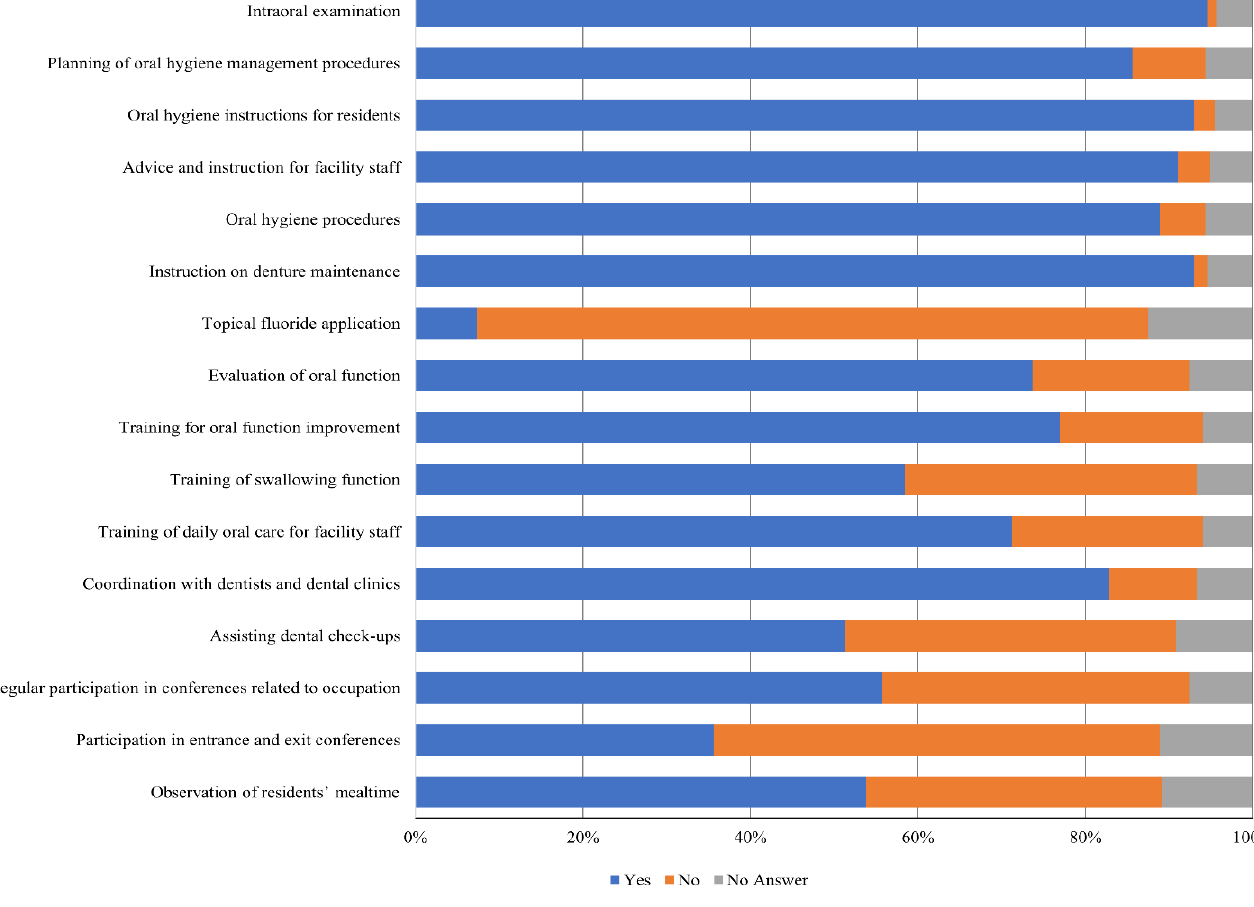
Figure 1. Performance of dental hygienists’ daily tasks when working in nursing facilities. The bar graph shows participants’ responses (in percentages) according to whether each task was performed by a dental hygienist at a nursing facility.